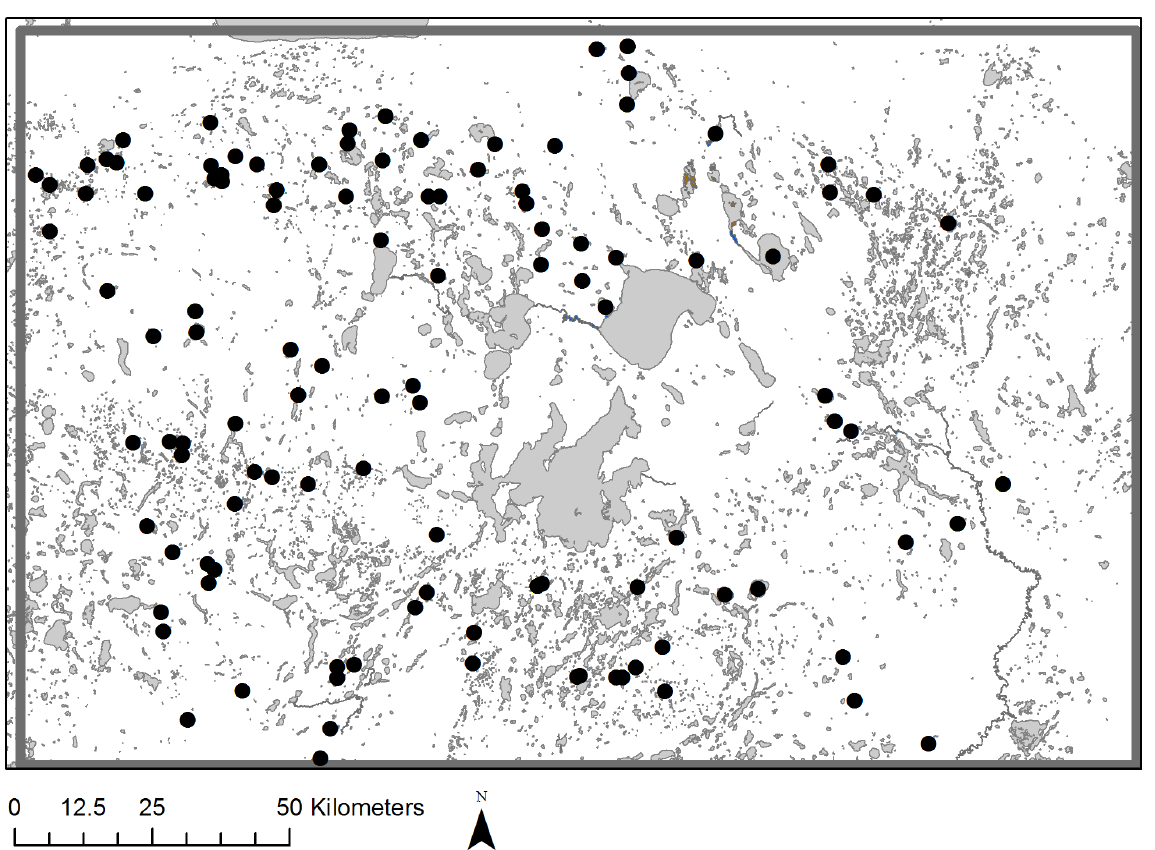
Figure 1. Study area and capture locations of young ring-necked ducks. Black dots indicate capture locations of birds on brood-rearing lakes in north-central Minnesota, USA during 2007–2010. Lakes and rivers are depicted in grey.